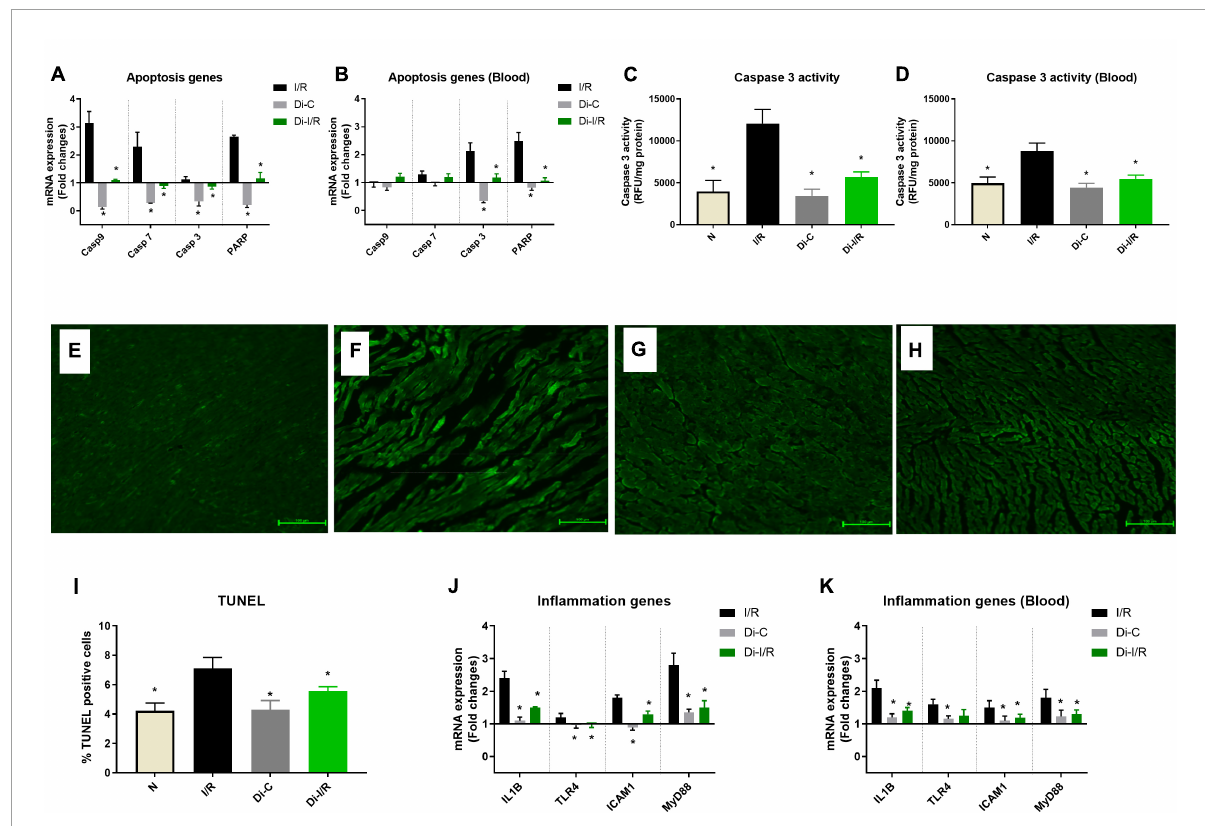
FIGURE5 Targeting DNA methylation during I/R reduced the apoptosis and inflammation in the myocardium and blood. The methylation impact of I/R on apoptosis and inflammation was assessed from (A) mRNA expression changes in the apoptosis genes in the heart; (B) Blood mRNA expression changes in the apoptosis genes; (C) Myocardial Caspase 3 activity; (D) Blood caspase 3 activity; The representative TUNEL stained images of the groups (E) normal; (F) I/R; (G) Di-C; (H) Di-I/R were obtained at 20 × magnification and the scale bars indicate 100 µ M. (I) Represents the apoptotic positive cells (TUNEL) percentage. Panel (J) represents the mRNA expression changes in inflammation genes in the myocardium and (K) represents the mRNA expression changes of inflammation genes in the blood. The graph represents the mean ± SD. The changes in gene expression are represented as fold changes from the normal group. * p < 0.05 vs.